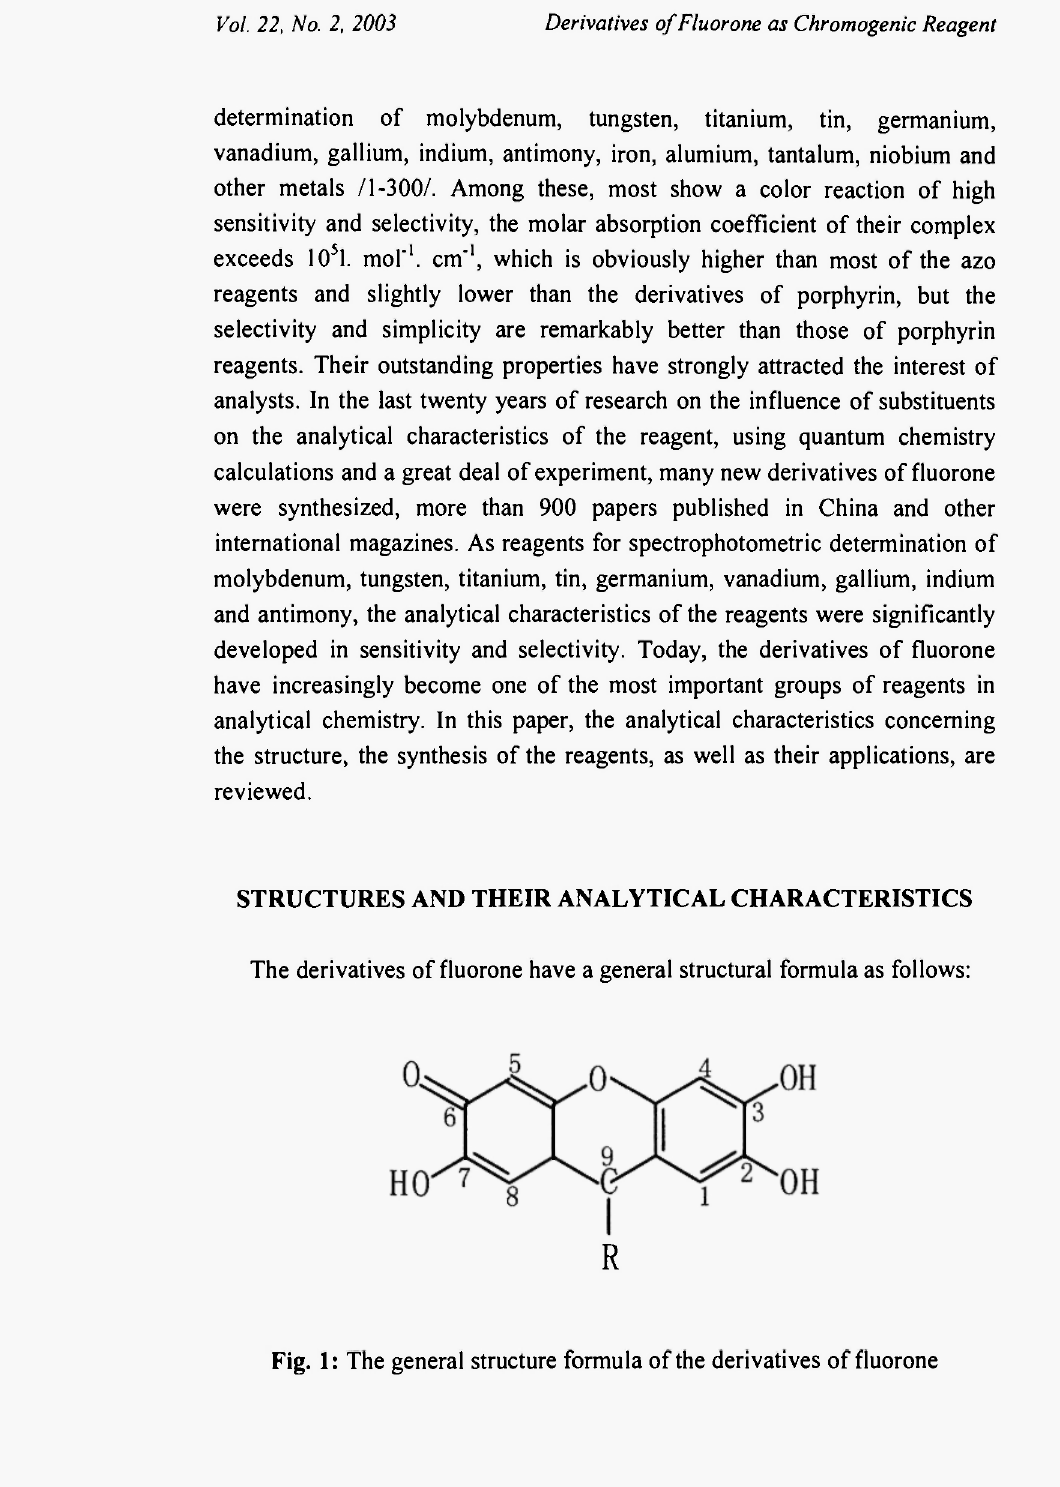
Fig. 1 : The general structure formula of the derivatives of fluorone